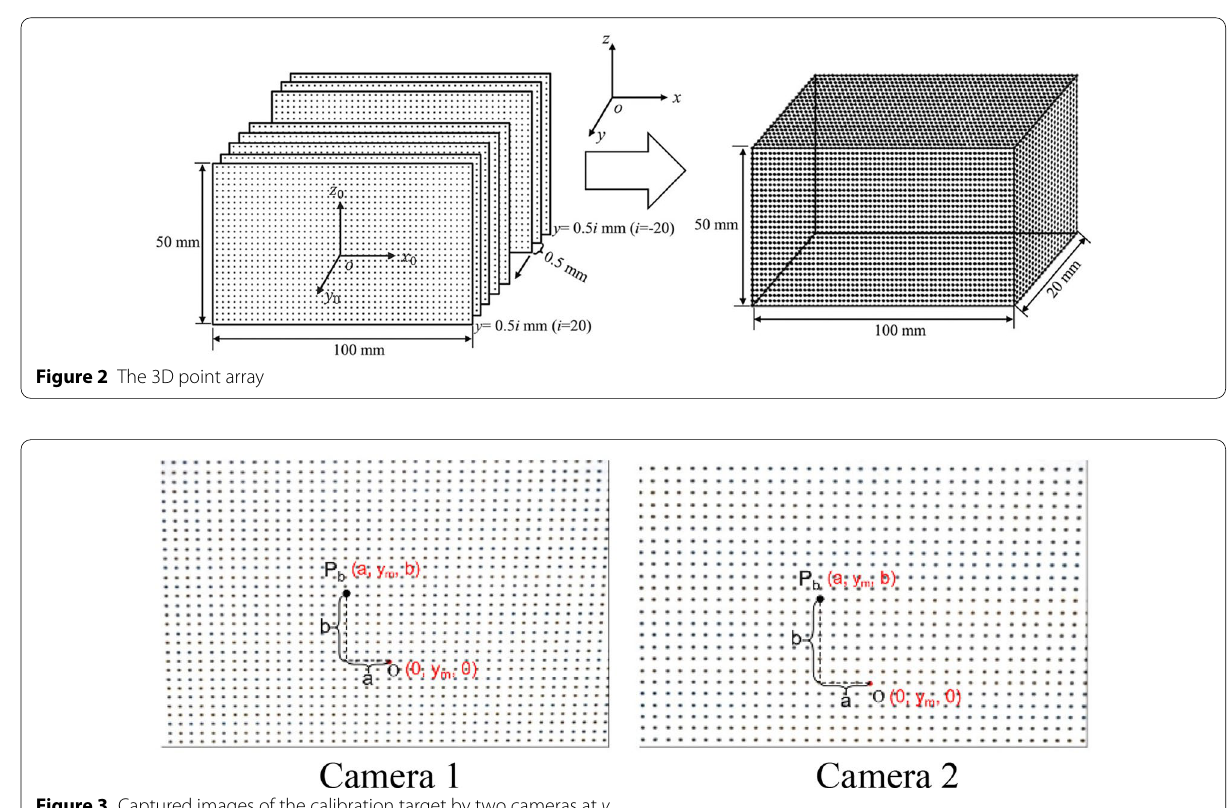
Figure 3 Captured images of the calibration target by two cameras at y